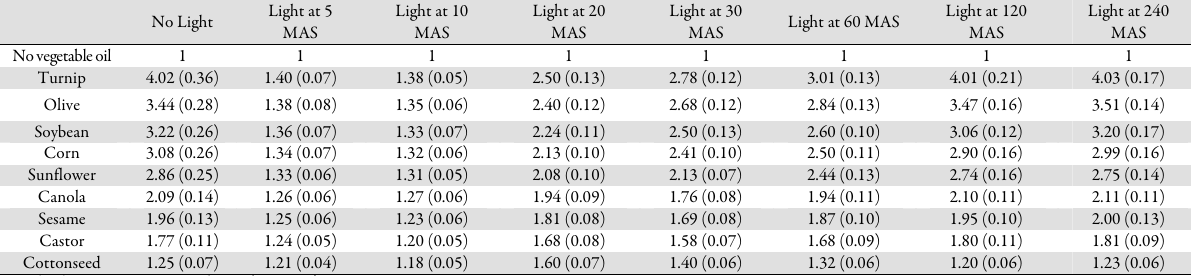
Tab. 2. Relative potency of sethoxydim (alone and in a mixture with vegetable oils) affected by light